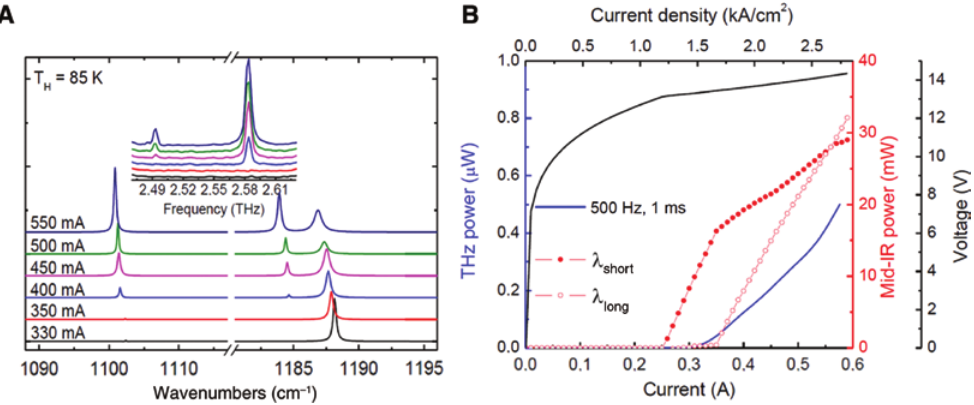
Figure 16: Emission spectra and power output of the DFG-QCL. (A) Mid-IR spectra of the DFG-QCL operating under CW mode at the heat sink temperature of 85 K. (B) Light-current-voltage characteristics of the DFG-QCL operating under CW mode at the heat sink temperature of 85 K. THz power was measured under quasi-CW mode with 500-Hz repetition frequency and 1-ms pulse width for requirement of a gating frequency for the Si bolometer [61].